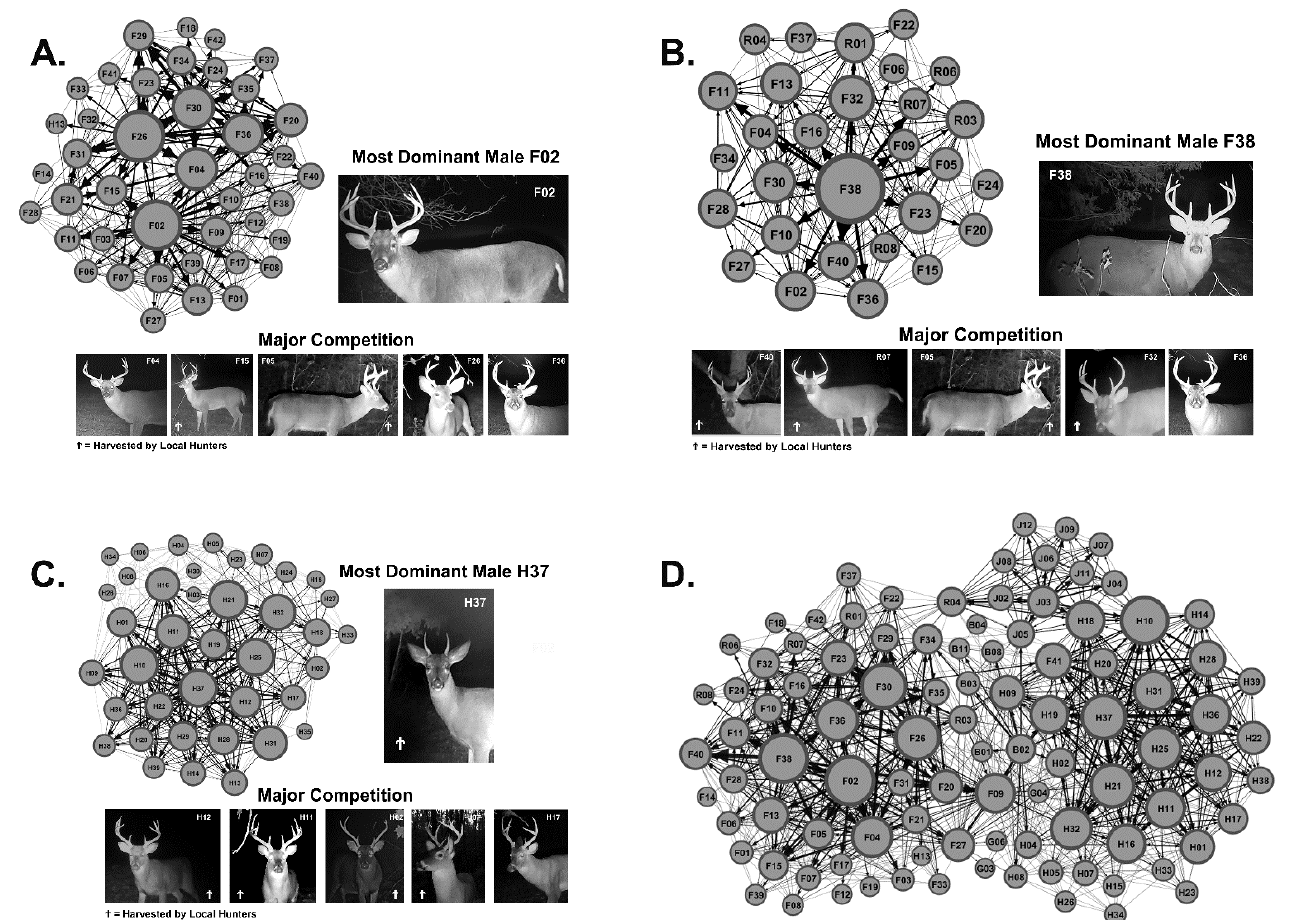
Figure 2. Local and Regional Social Networks. Shown are the local community networks and the region-wide social network generated using scraping network analysis. ( A ) Shown is the local community network generated from Site 1 data and images of the most dominate male F02 and his major competition. The node size in each graph varies as a factor of total weighted degree. Ϯ Indicates male WTD harvested by local hunters. ( B ) Shown is the local community network at Site 2 and images of the most dominate male F38 and his major competition. ( C ) Shown is the local community network at Site 3 and images of the most dominate male H37 and his major competition. ( D ) Shown is the region-wide social network (i.e., Regional Network) generated from Sites 1, 2, and 3 as well as boundary sites’ data.